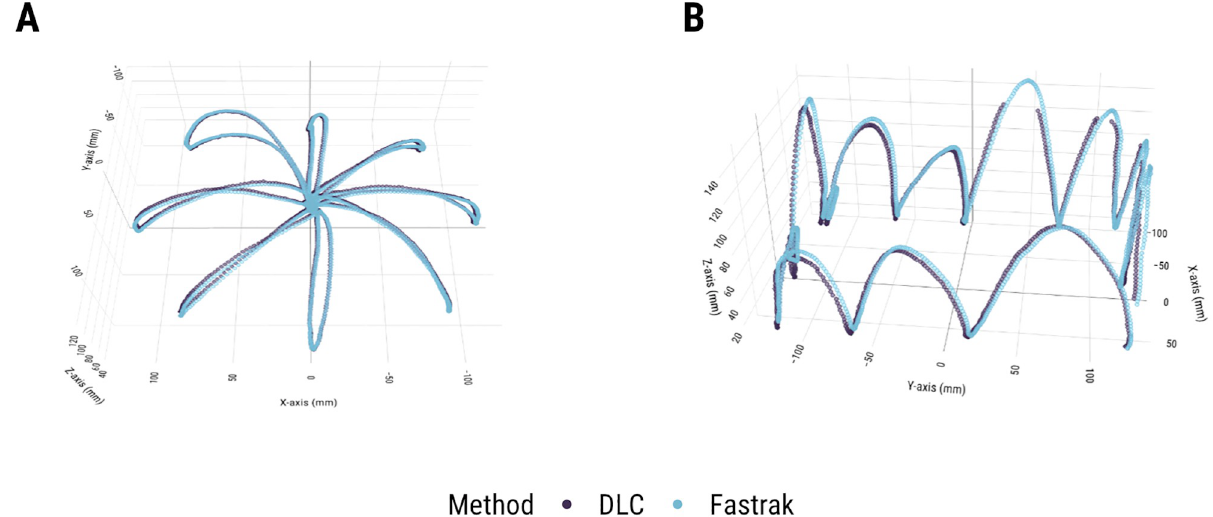
Fig 2. (a) Representative example of raw single trial data from the center-out (tool) task; (b) Representative example of raw single trial data from the zigzag (tool)